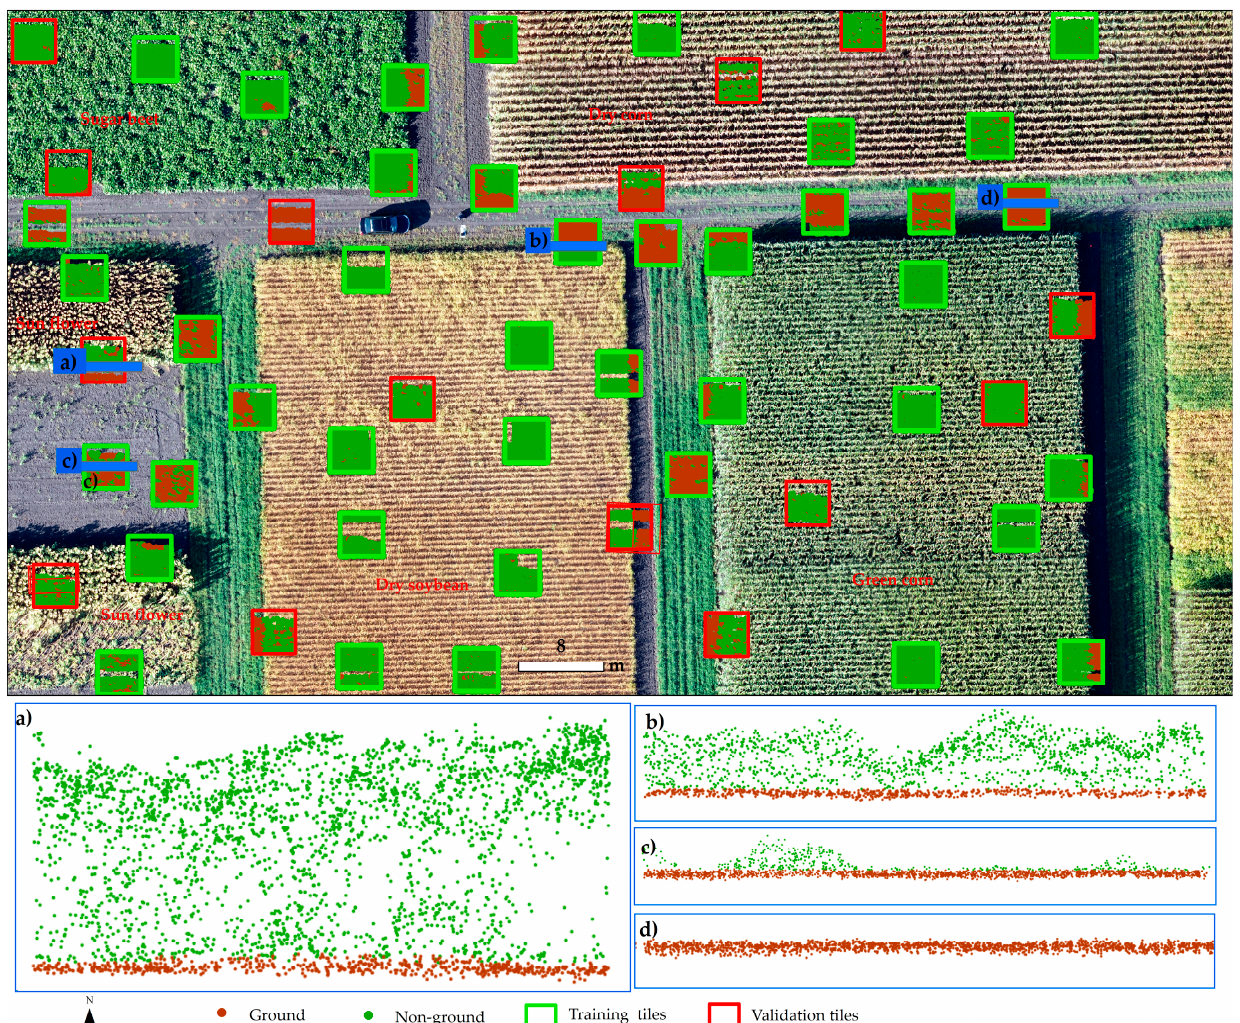
Figure 4. Site A. Example of training, validation, and benchmark data. Three ‐ dimensional transects of point clouds training data of ( a ) sunflower, ( b ) soybean, ( c ) ground with some weeds, ( d ) ground. Three ‐ dimensional transects ( a – d ) are of the same extent (horizontal) for visualization purposes with no vertical scale.